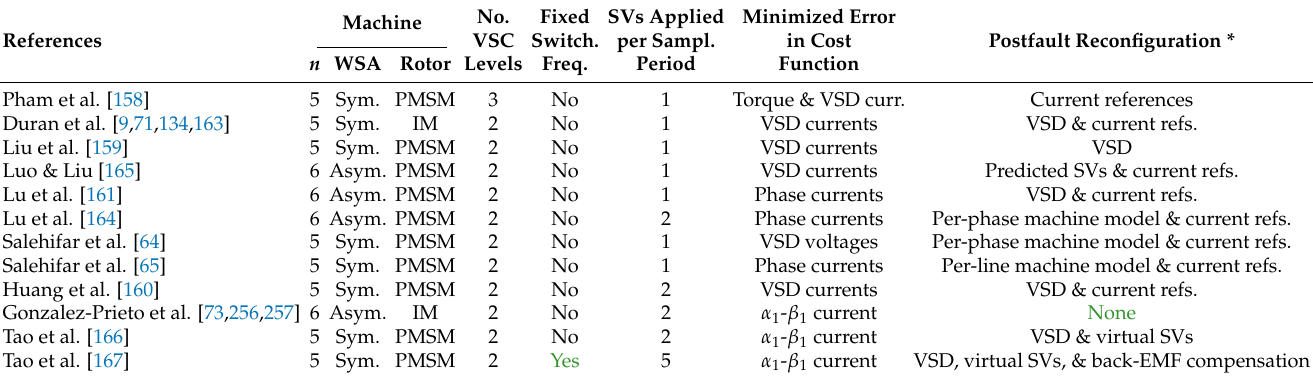
Table 8. Methods based on RFOC with current FCS-MPC for tolerating phase OCs (Section 3.4.2) in multiphase applications in the